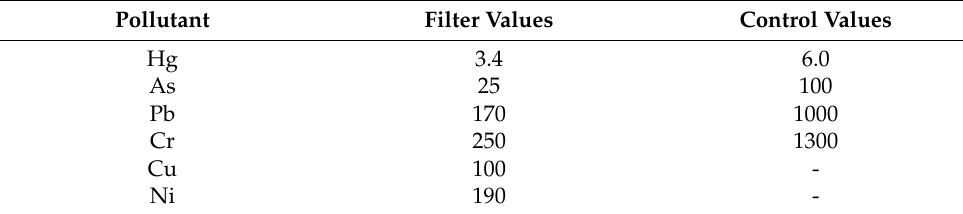
Table 3. Filter and control values of the PTE pollution risk for farmlands (mg/kg).